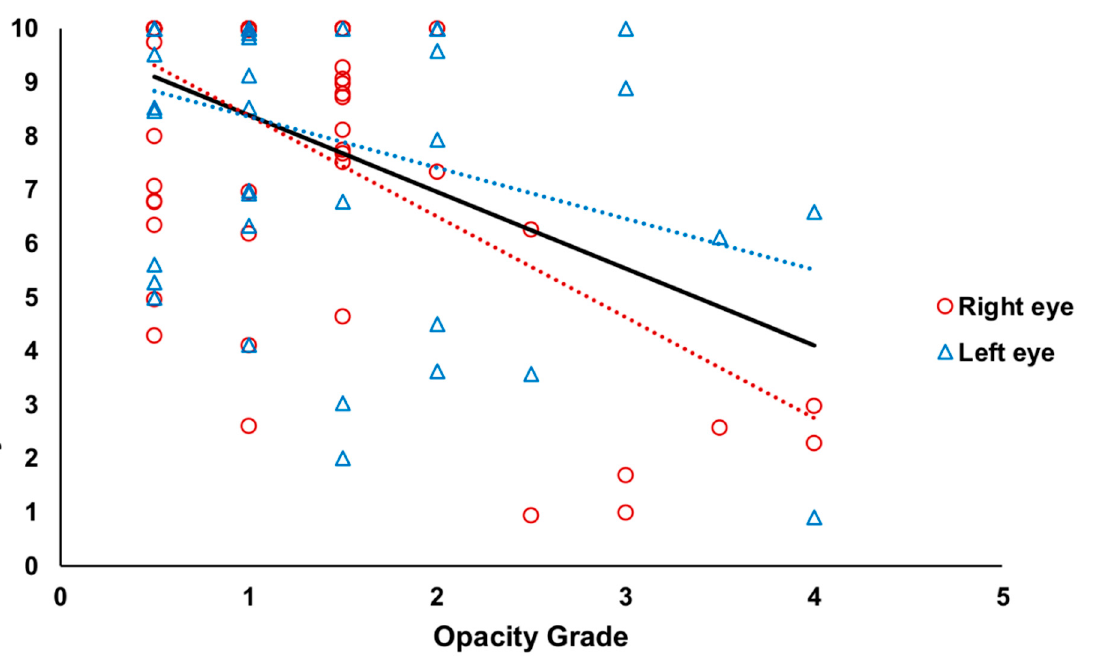
Figure 2. Scatter plot of the relationship between Dysfunctional Lens Index and Opacity Grade. Black, red, and blue lines indicate the tendency lines of all, right, and left eyes, respectively. red, and blue lines indicate the tendency lines of all, right, and left eyes,